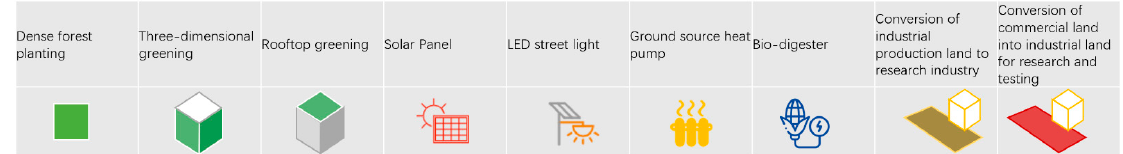
Figure 10. ( a ) Carbon emission and carbon sink distribution of the Xiajiabian Station TOD Complex in 100 × 100 m unit, ( b ) Carbon emission and carbon sink distribution of the Fisherman’s Island TOD Complex in 100 × 100 m unit.